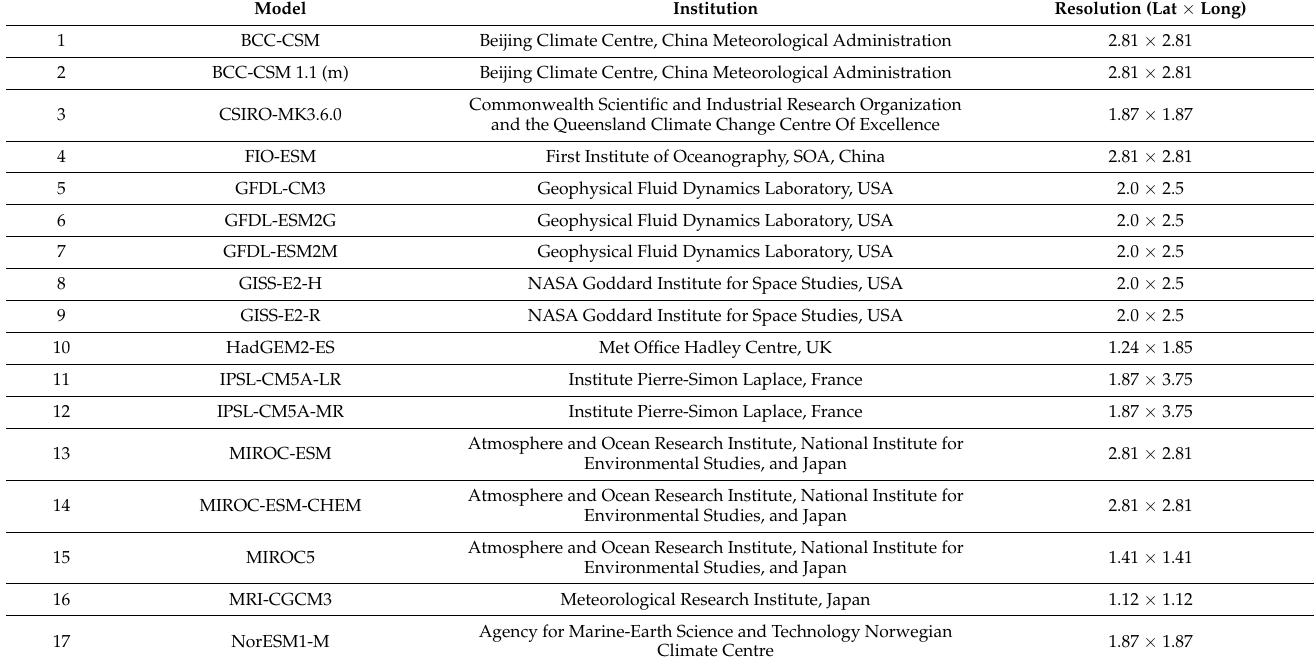
Table 1. Various MarkSim General Circulation Models